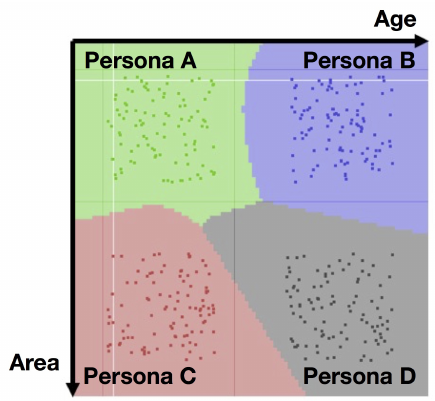
Figure 14. Example of classification result by multi-layer